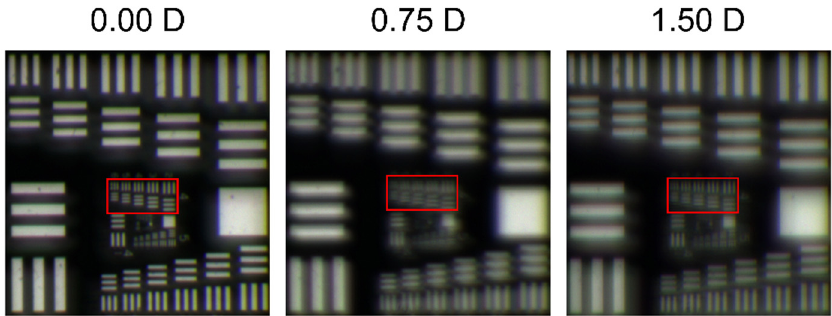
Figure 5. Experimental polychromatic USAF test images, at different vergences, obtained for a 30 D power lens with 3.0 mm pupil diameter.